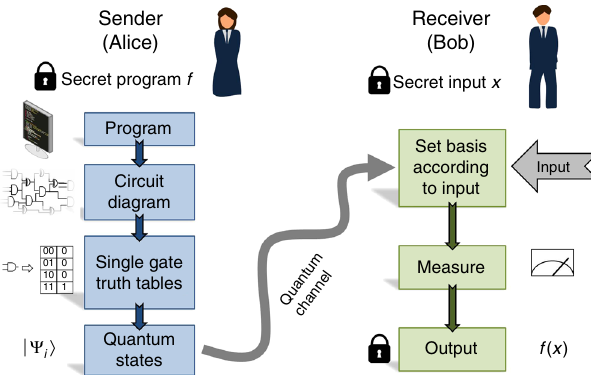
Fig. 1 Overview of a probabilistic one-time program scheme.